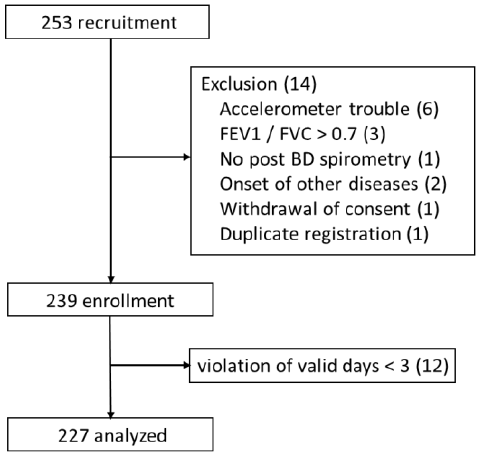
Figure 1. CONSORT diagram. Abbreviations: FEV1, forced expiratory volume in one second; FVC, forced vital capacity; BD, bronchodilator .